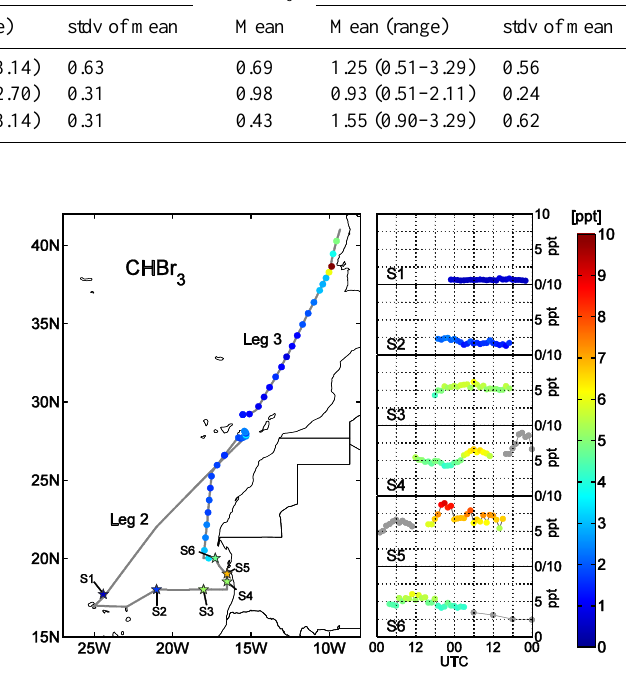
Fig. 7. Bromoform mixing ratios [ppt] measured during the DRIVE ship campaign from 31 May to 24 June 2010. Six 24h stations (S1– Fig. 7: Bromoform mixing ratios [ppt] measured during the DRIVE ship campaign from 694 S6) and measurements during transit are colour-coded according to the scale on the right 31.05. to 24.06.2010. Six 24 hr stations (S1 – S6) and measurements during transit are color-695 coded according to the scale on the right side. 696 697